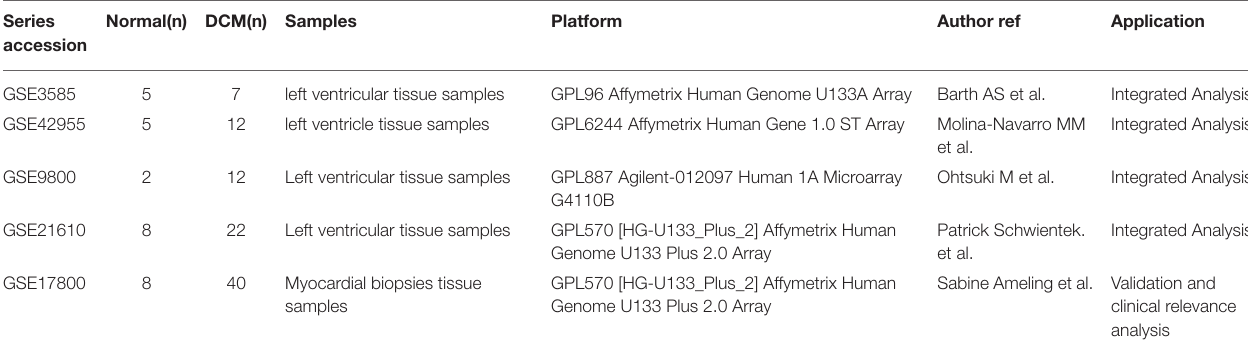
TABLE 1 | The characteristic baseline of microarray. Series Normal(n) DCM(n) accession